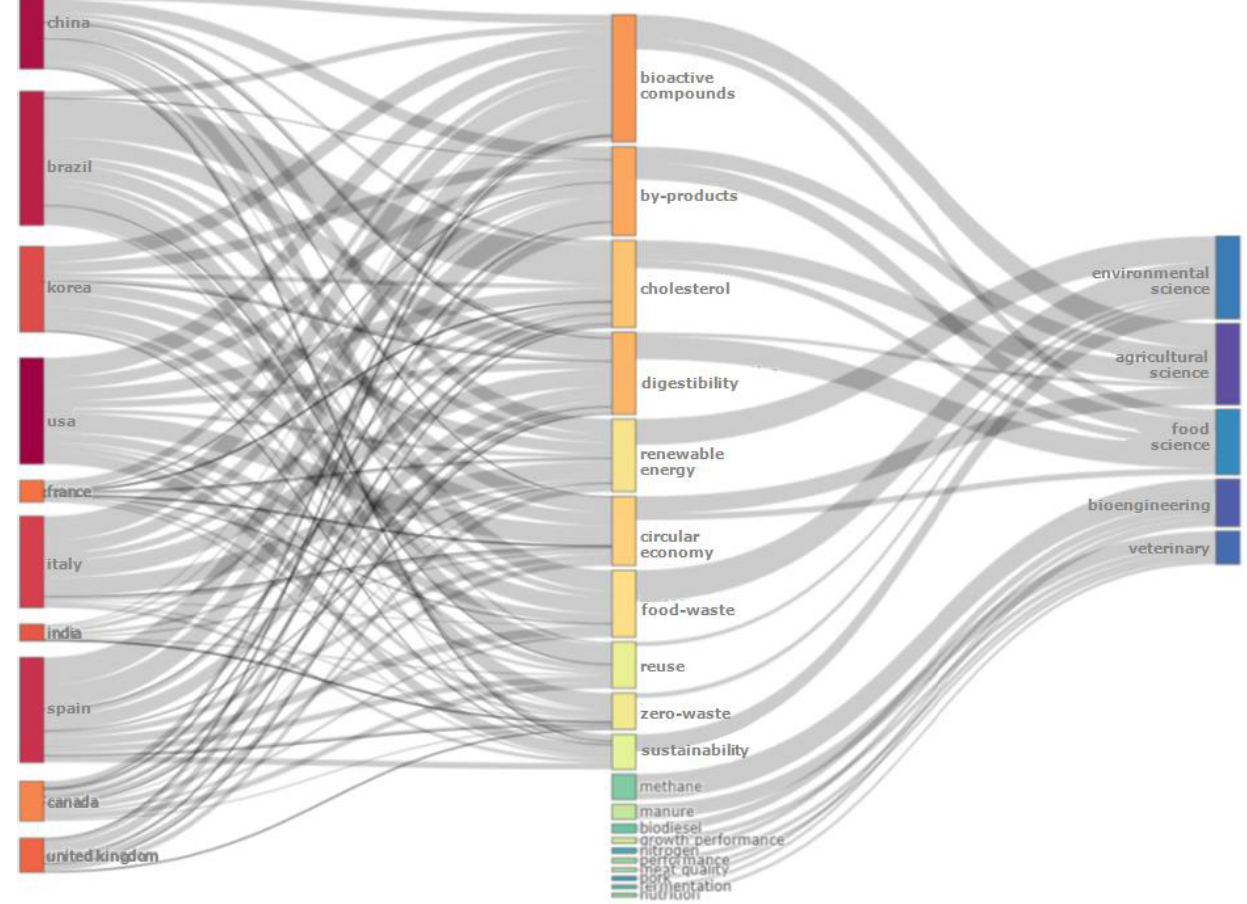
Figure 6. Three-field tree plot showing the existing connection between the main countries contributing to the search topic, the most used keywords in the articles, and the main research areas. The three semantic areas are connected by a gray plot. The box size beside the terms indicate the frequency in publications, while the different coloring indicates the frequency of connections (red: higher frequency; blue: lower frequency).